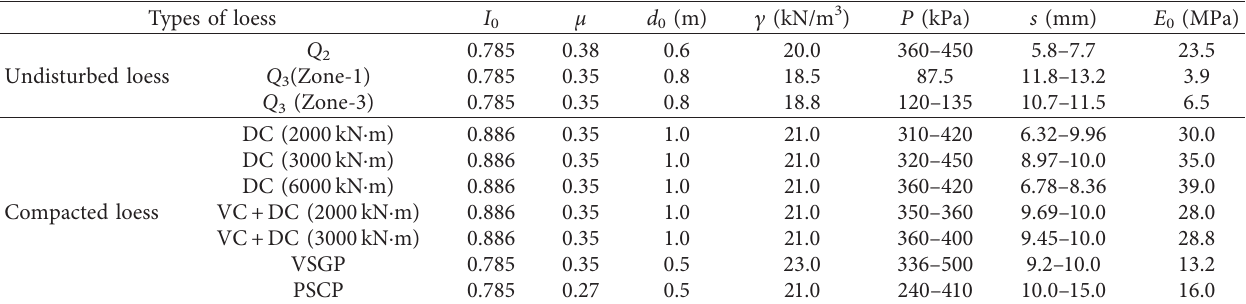
Table 4: Plate load test results of loess before and after DC with different reinforcement methods. Types of loess